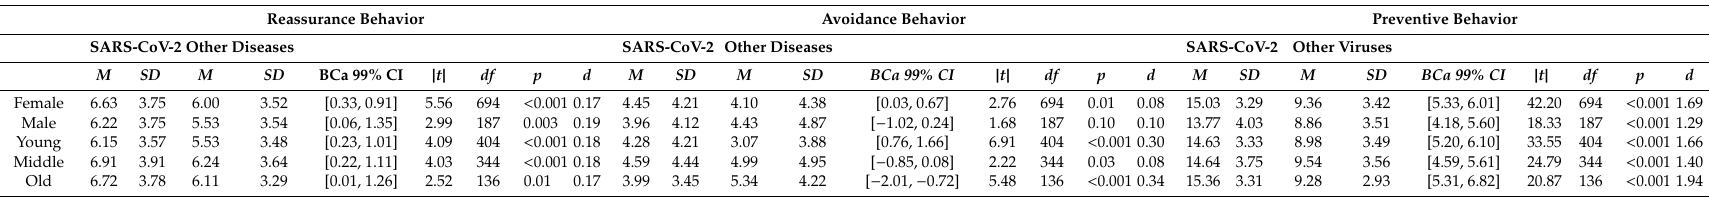
Table 2. Results of the dependent (paired) sample t-tests of reassurance, avoidance, and preventive behavior in relation to SARS-CoV-2 and in relation to other diseases in the subgroups female and male, and the age subgroups “young” (18–29), “middle” (30–59), and “old” ( ≥ 60 years). Reassurance Behavior Avoidance Behavior Preventive Behavior SARS-CoV-2 Other Diseases SARS-CoV-2 Other Diseases SARS-CoV-2 Other